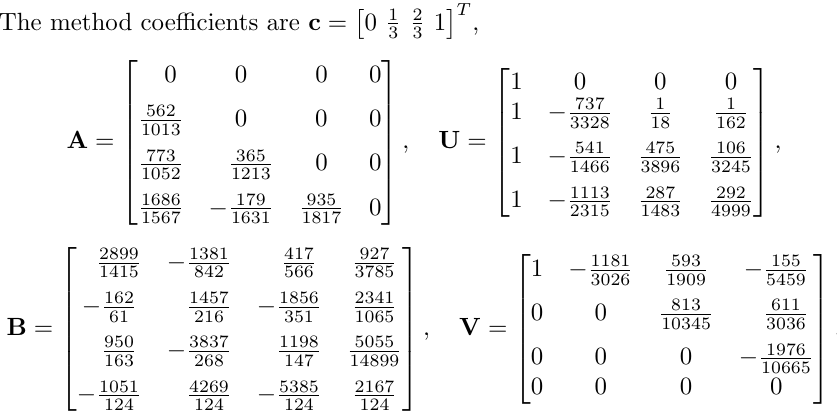
The method coefficients are c =